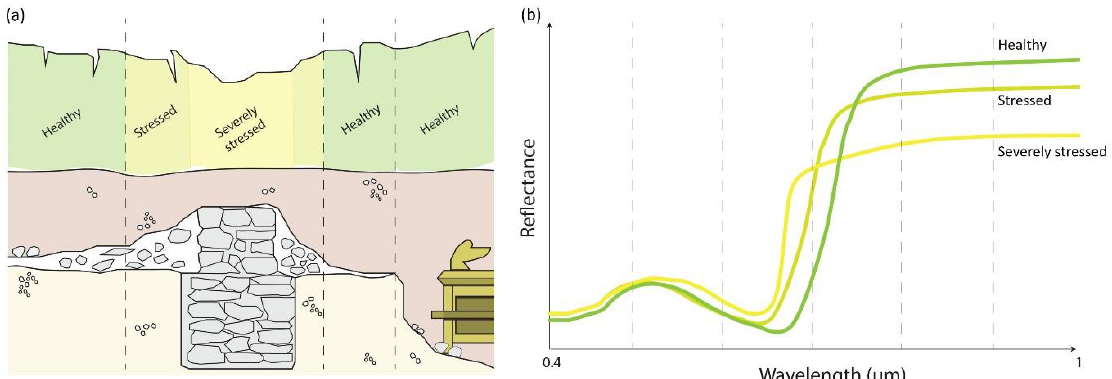
Figure 9. Example of crop-marks pattern in relation to the presence of buried remains (drawn by the authors): ( a ) illustrative diagram of the reaction of the health of the vegetation in relation to the subsoil; ( b ) illustrative diagram of the reflectance recorded in cases similar to ( a ).